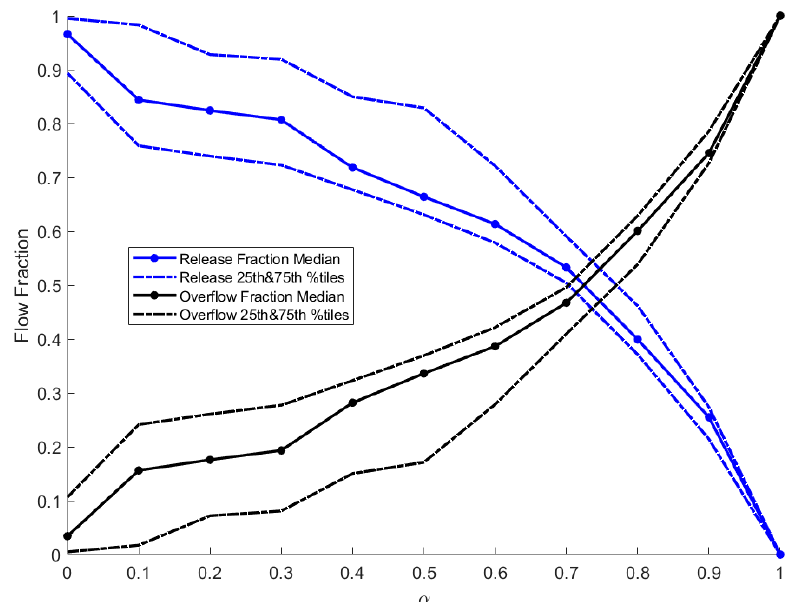
Figure 7. Overflow and controlled release as fractions of the total loss flow (overflows + controlled release). As more water is released from the tank, the fraction of the released water from the overall outflows increases.